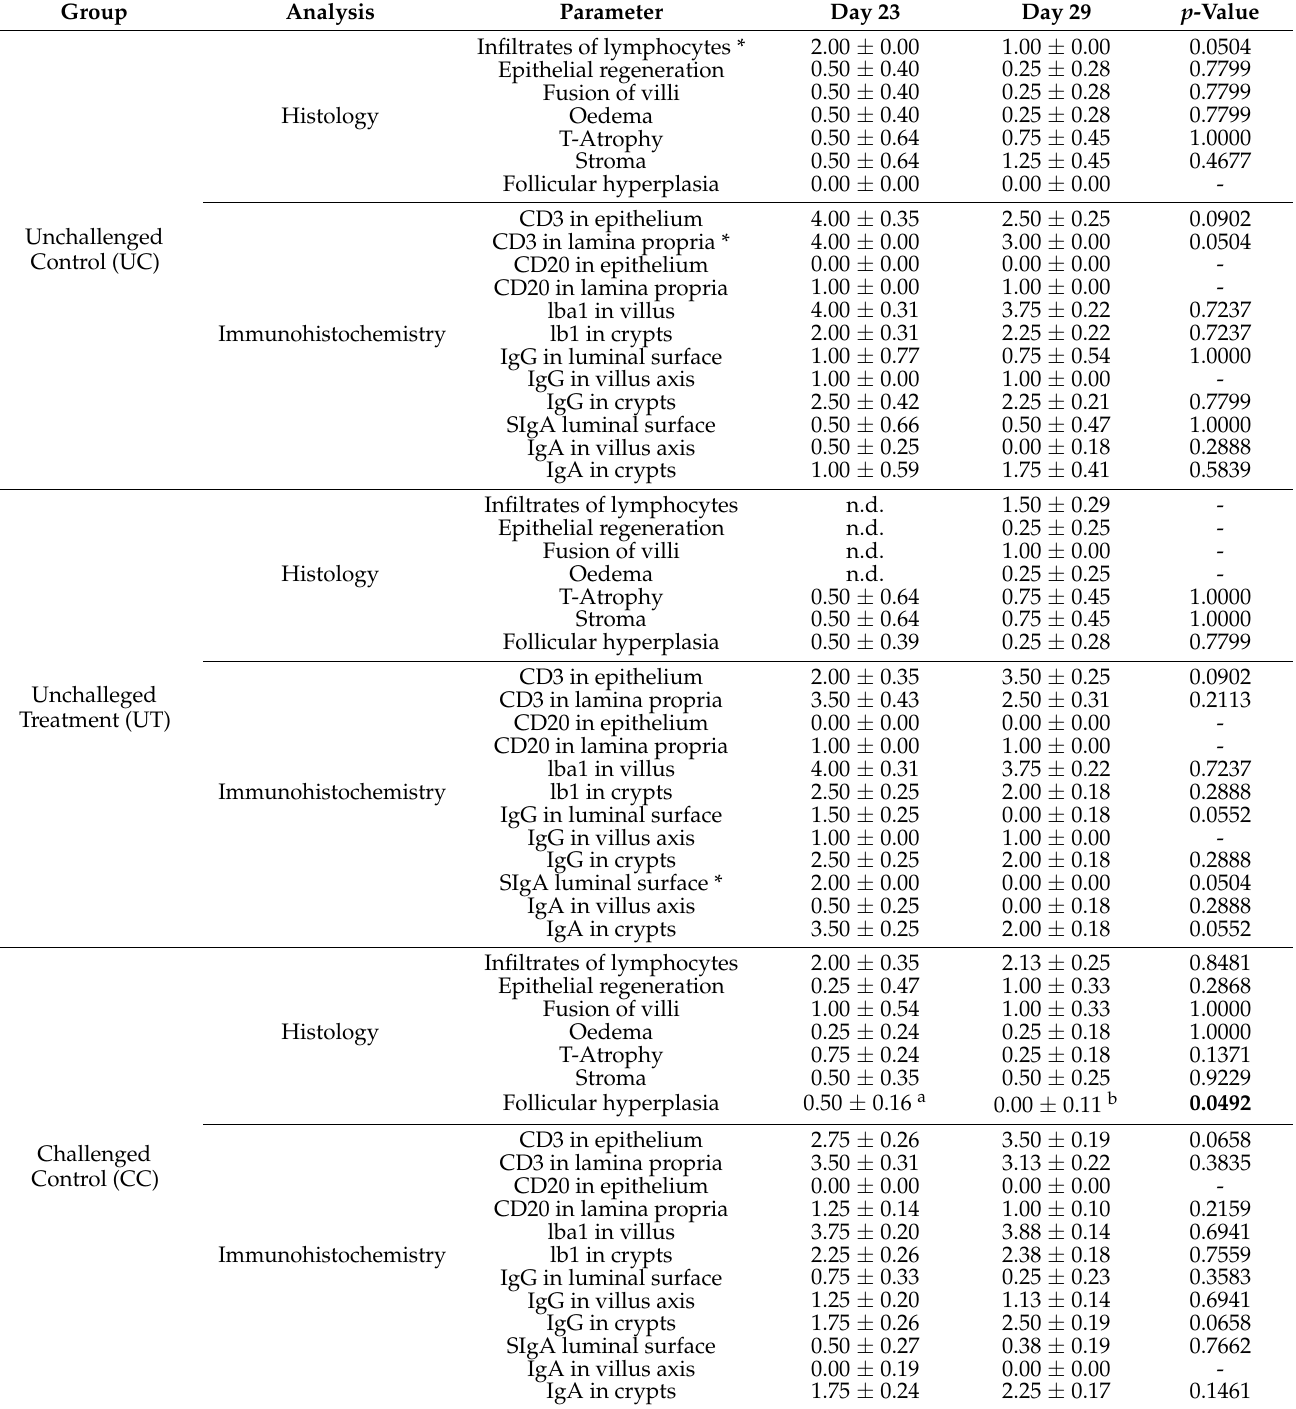
Table 3. Mean values of the histological parameters of the ileum sections recorded at 23 and 29 days divided by experimental groups. p -Value most significant in